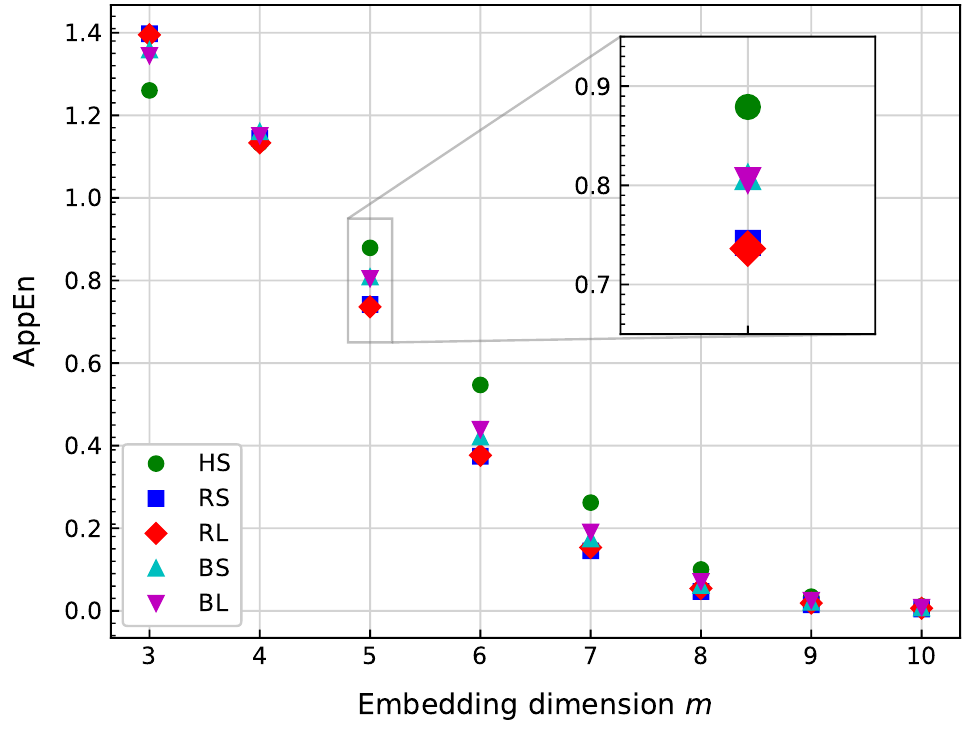
Figure 9. Comparison of the approximate entropy (AppEn) mean value for several bearing signals at the same rotational speed. The calculation uses r = 0.2 × σ , W s = 10,240, and varying m